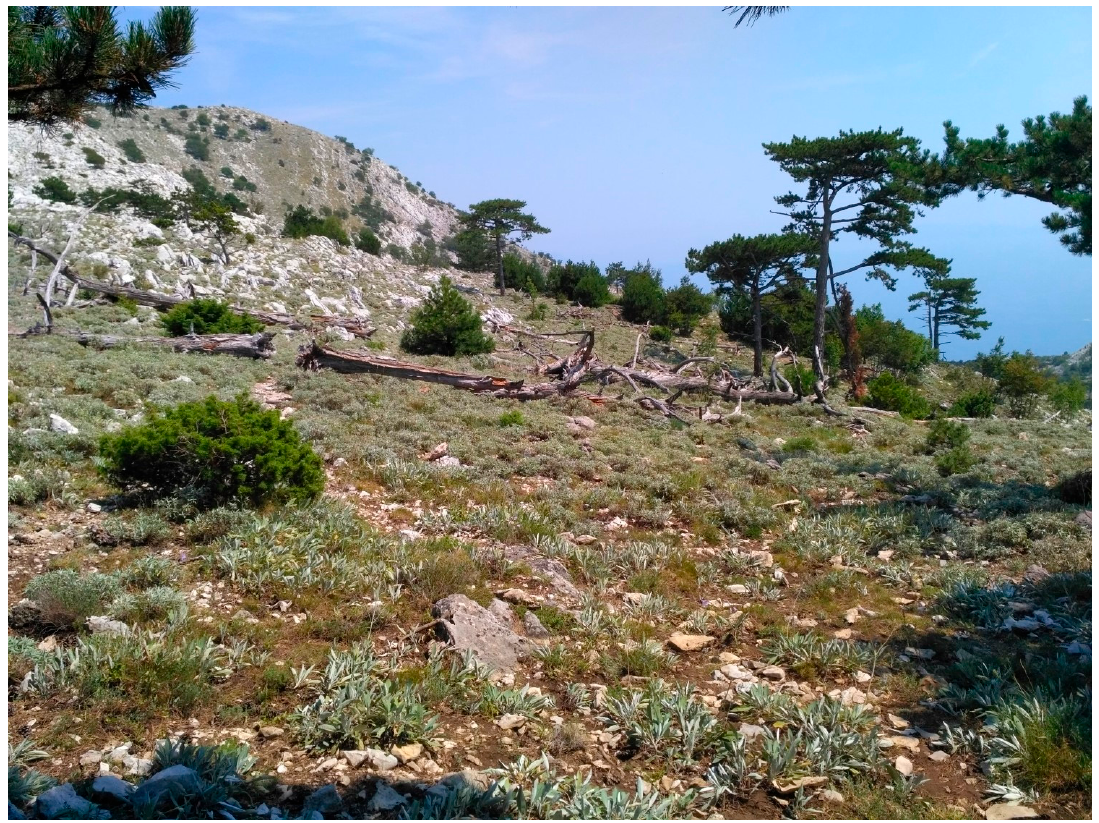
Figure 1. View of the studied Salvia brachyodon population. Numerous S. brachyodon patches can be seen in the front and burned trunks remaining after the wildfire in the back.